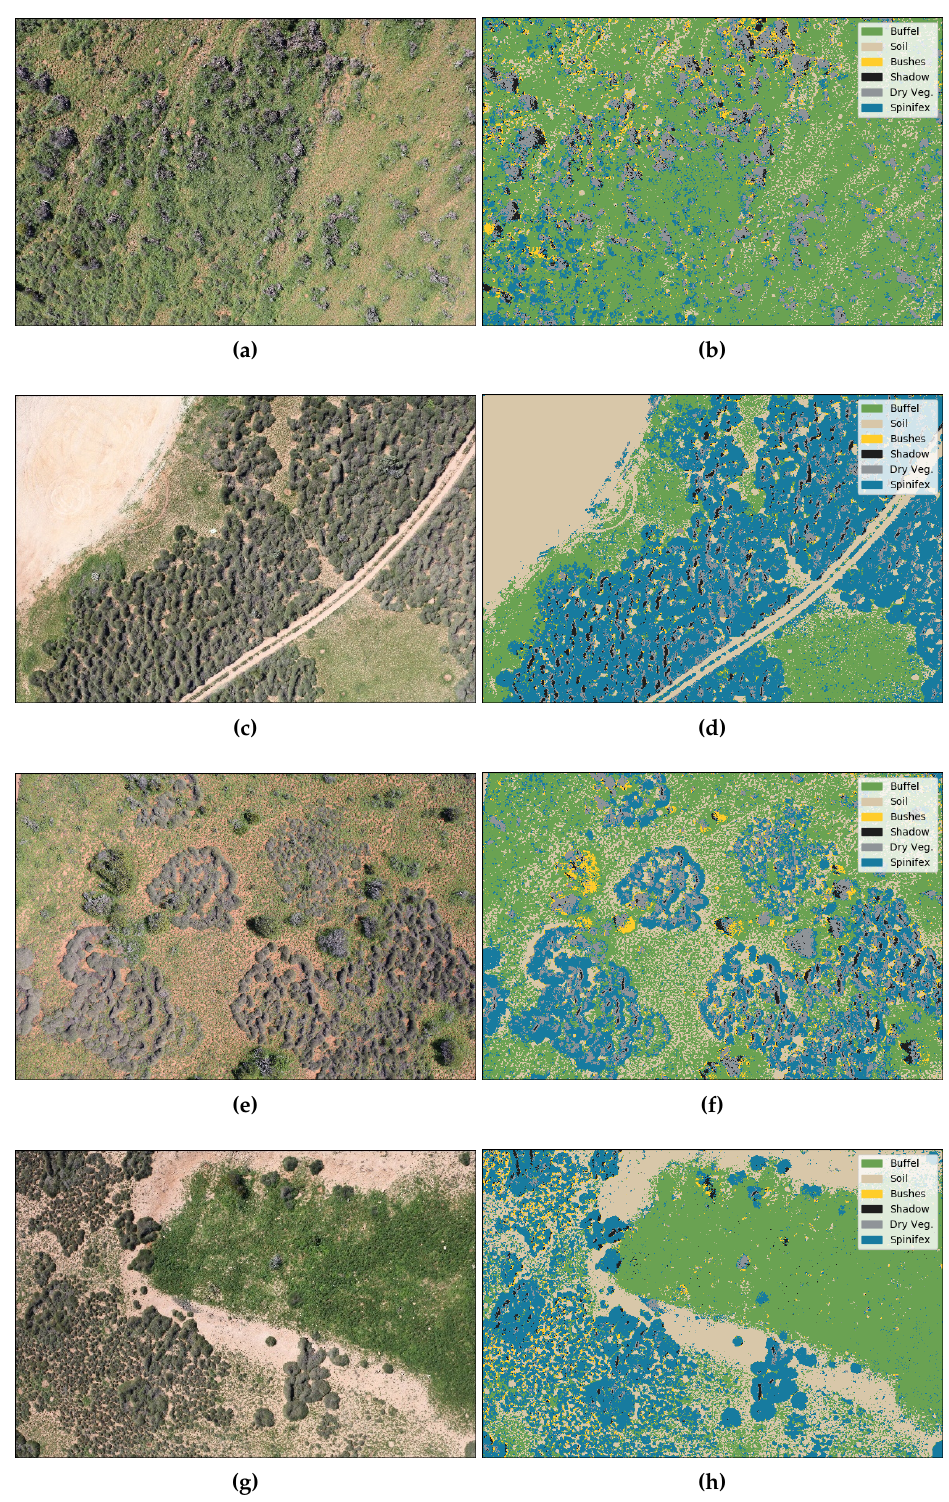
Figure 6. Pixel-wise segmentation from acquired red, green, blue (RGB) colour model images using Algorithm 1. ( a , c , e , g ) Orthorectified RGB images. ( b , d , f , h ) Final segmentation with predicted